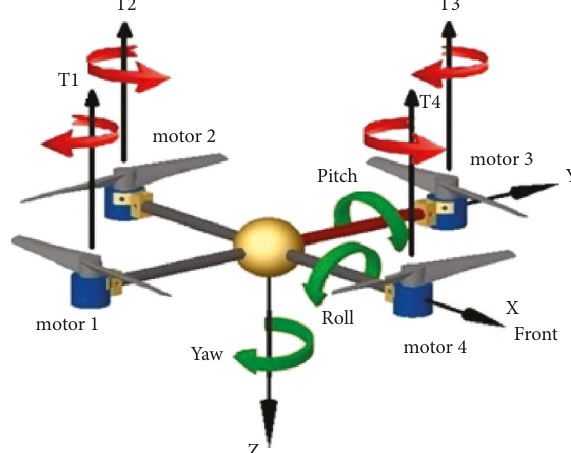
Figure 1: Quadcopter